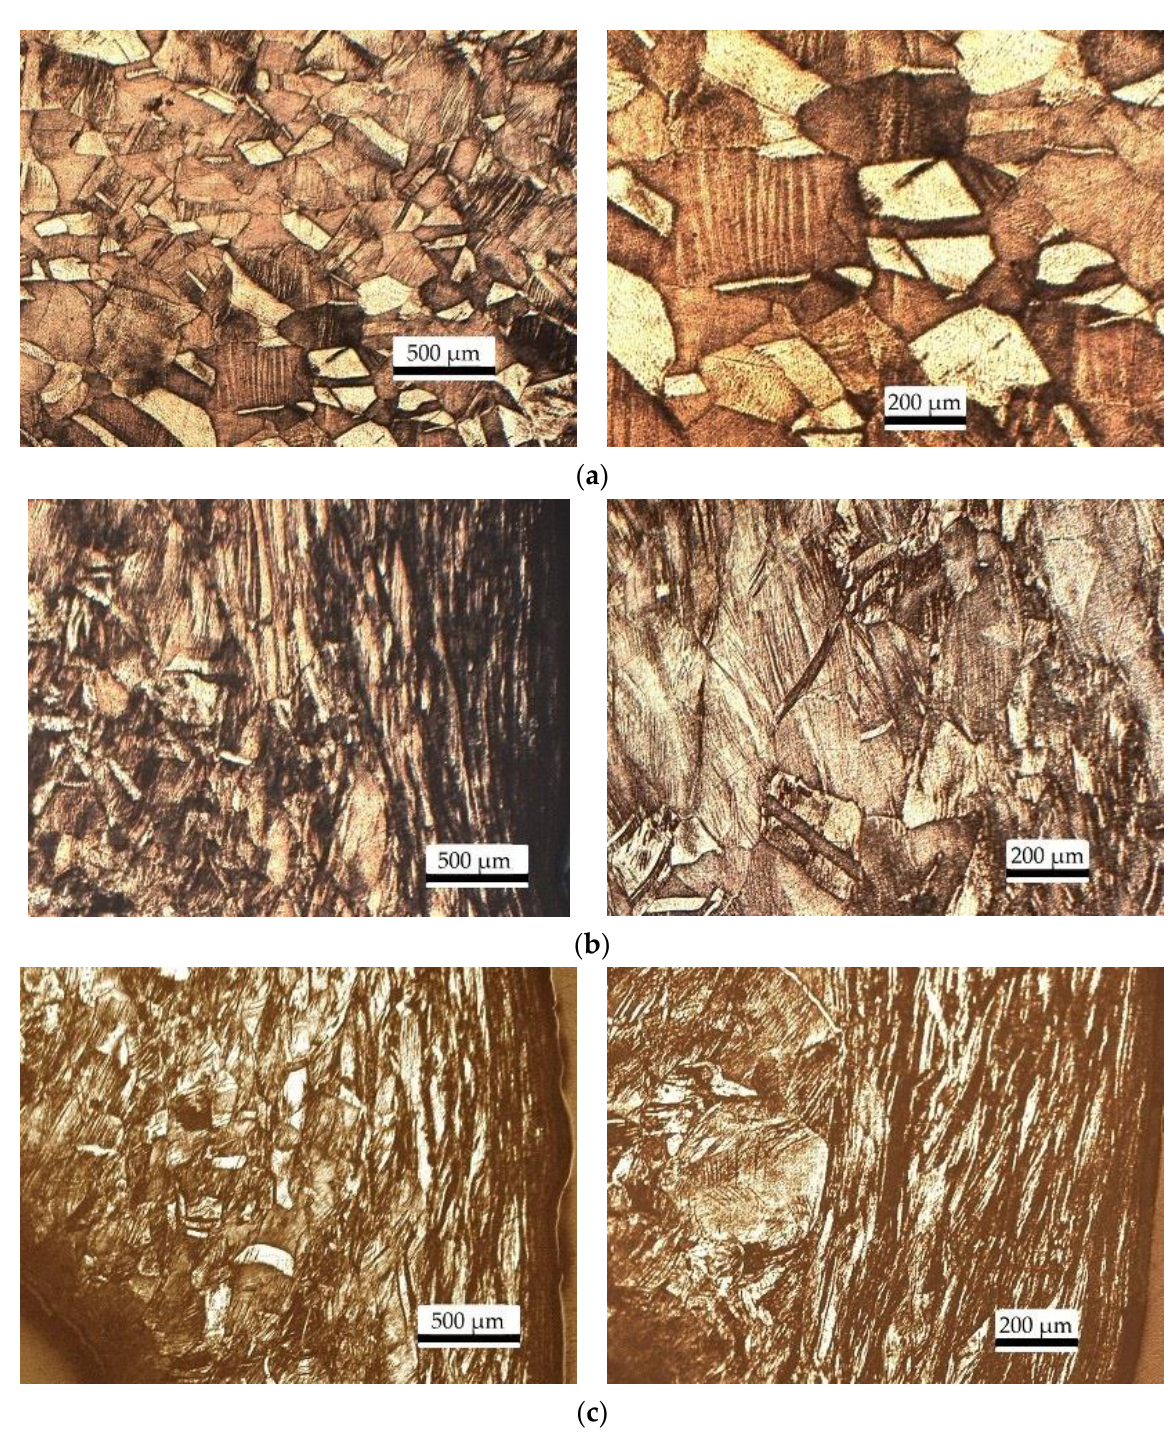
Figure 10. Microstructure in the plastic deformation zone ( a ), intense plastic deformation zone ( b ), and fracture zone ( c ) of the specimen for an impact velocity of 316 m/s.